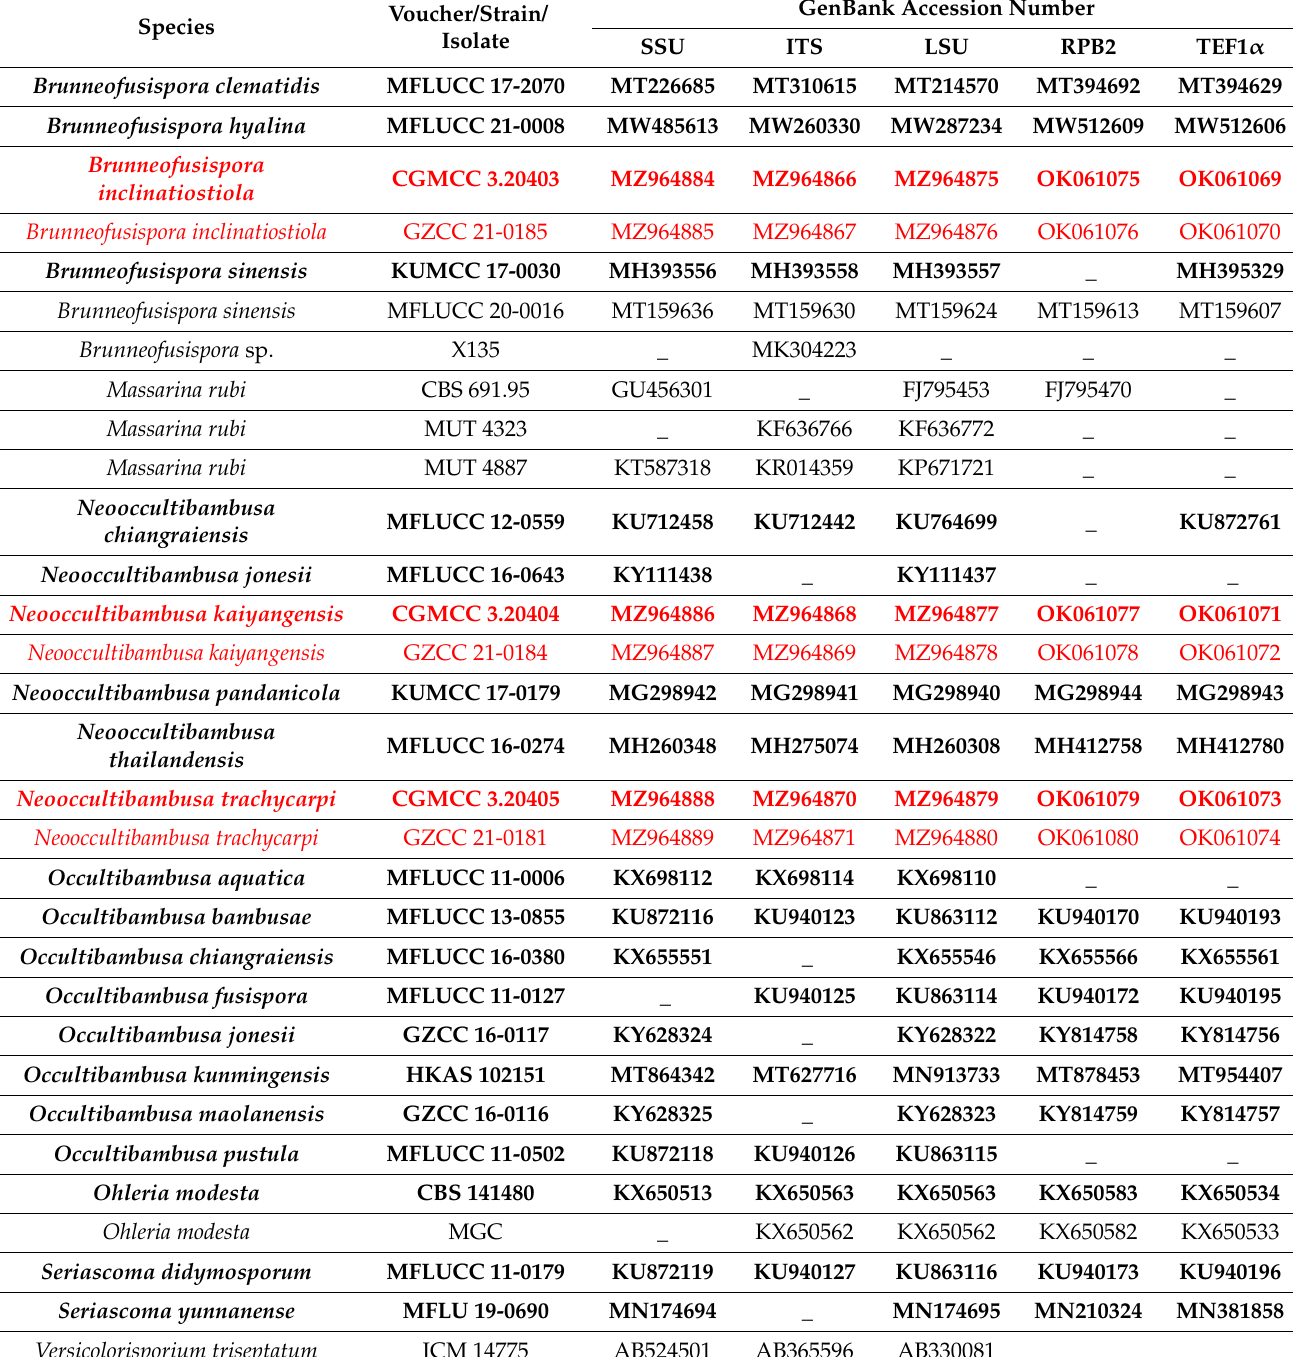
Table 1. Taxa used in the phylogenetic analyses and their corresponding GenBank accession numbers. The ex-type strains are indicated in bold and newly generated sequences are indicated in